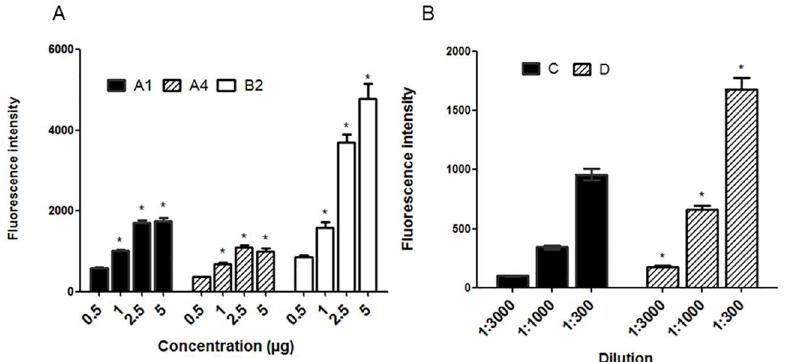
Fig 2. Evaluation of the best conjugate concentration and dilution. A: Anti-IgG-PE concentration test (0.5, 1, 2.5 and 5 μ g/mL). * = statistically different value when comparedto the lowest concentration (p (cid:20) 0.05). A1- black bars, A4- dashed bars and B2- white bars. B: Anti-HBSAg-PE dilutiontest (1:3000,1:1000 and 1:300). C- black bars and D- dashedbars. One way ANOVA was performed for group comparison * = statistically different value among concentrations (p (cid:20) 0.05). Data are expressedas mean of three geometric means ± standard